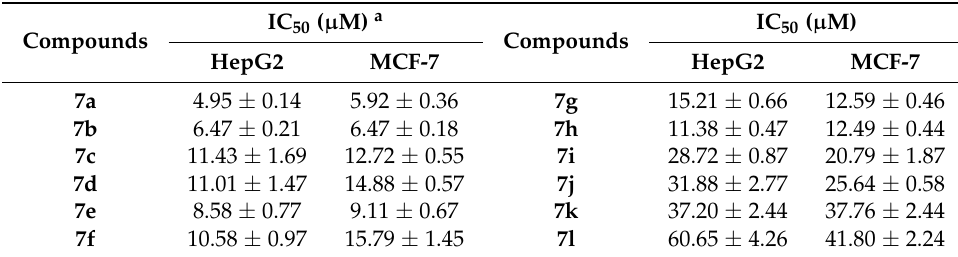
Table 3. Anti-proliferative activities of compounds 7a – 7l . Compounds